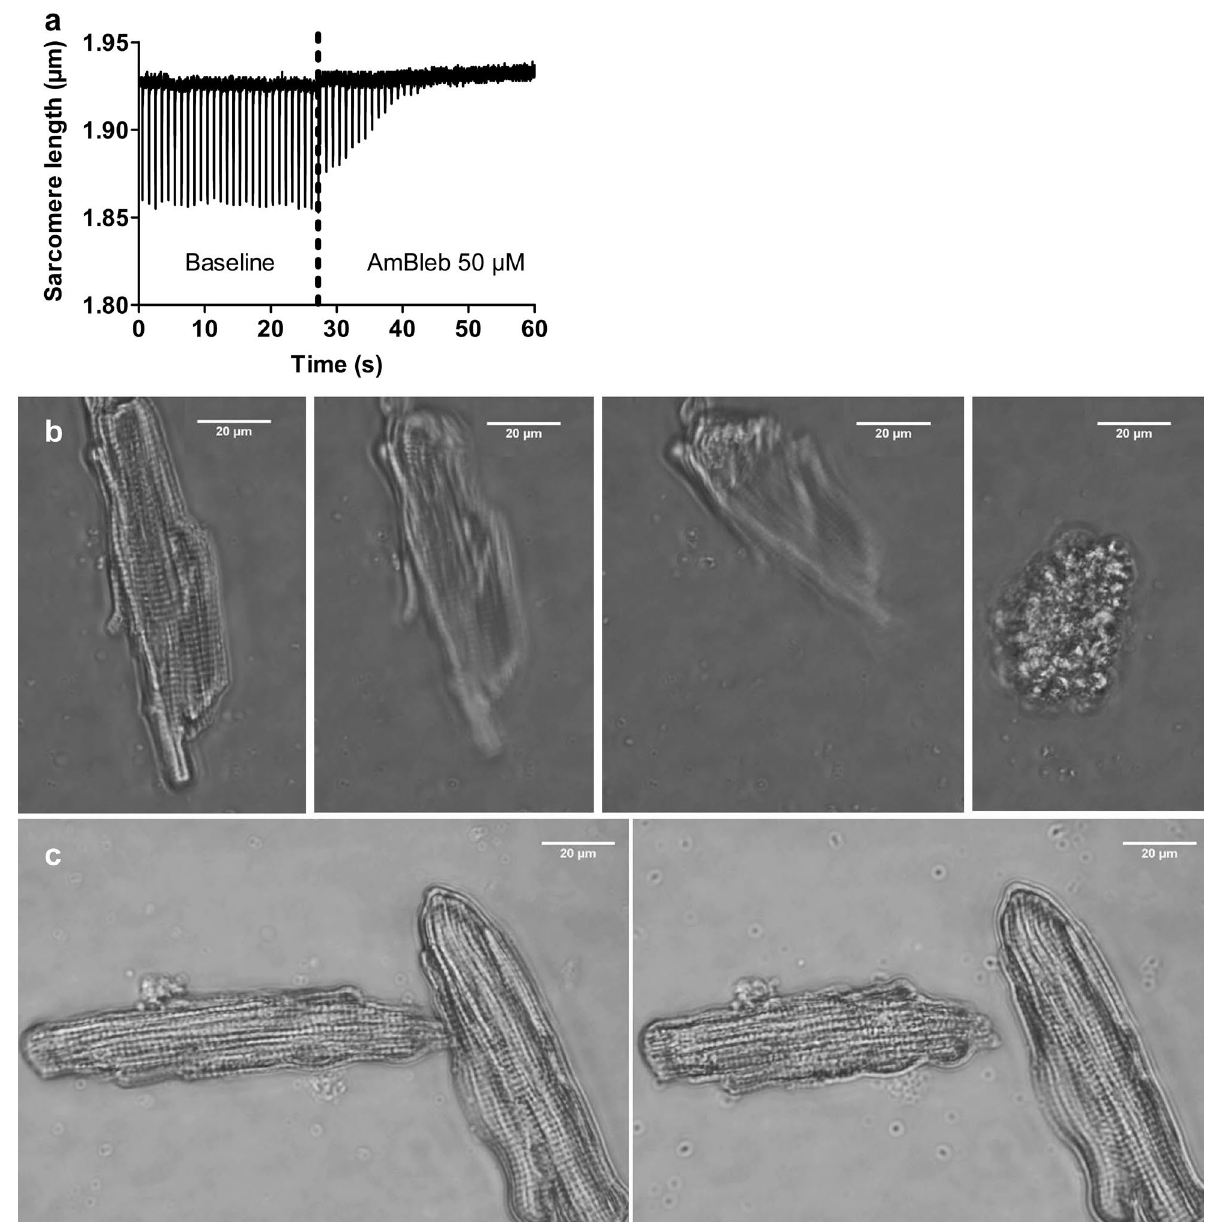
Figure 6. The myosin inhibitor AmBleb abrogated hypercontraction of intact cardiomyocytes exposed to Mt-II. ( a ) Electrically induced (1 Hz) shortening of a viable cardiomyocyte (baseline). The experiment is essentially the same as that depicted in Fig. 4a, but before FURA-2 loading, so that only sarcomere length can be acquired. The dotted line shows the timing of administration of a bolus of HEPES solution containing AmBleb, yielding an AmBleb concentration of 50 µM in the chamber (the small drift of the signal is an artifact resulting from the bolus administration). In less than 20 s, the cell becomes stagnant to the electrical stimulus. Image created using GraphPad Prism (version 5.01) www. graph pad. com. ( b ) Bright field microscopy of an intact cardiomyocyte shortly after exposure to 50 µg/mL Mt-II. Note the strong, irreversible shortening, i.e., hypercontraction. The sequence of pictures was obtained from the supplementary video 4. ( c ) Bright-field microscopy of two intact cardiomyocytes shortly after exposure to 50 µg/mL Mt-II, this time in presence of 50 µM AmBleb. In spite of a partial shortening (right picture in c ), the difference with the end state in ( b ) is substantial. The sequence of pictures was obtained from the supplementary video 5 (see Fig. S2 in the supplementary information for additional photos at lower magnification). Experiments shown in ( b , c ) were performed in HEPES solution. Images ( b ) and ( c ) acquired and processed using Olympus cellSens (version 2.3); https:// www. olymp us- lifes cience. com/ de/ softw are/ cells